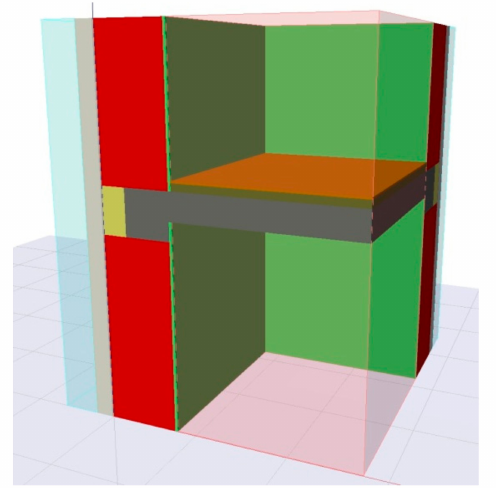
Figure 15. Corner model in the Psi-Therm 3D program.